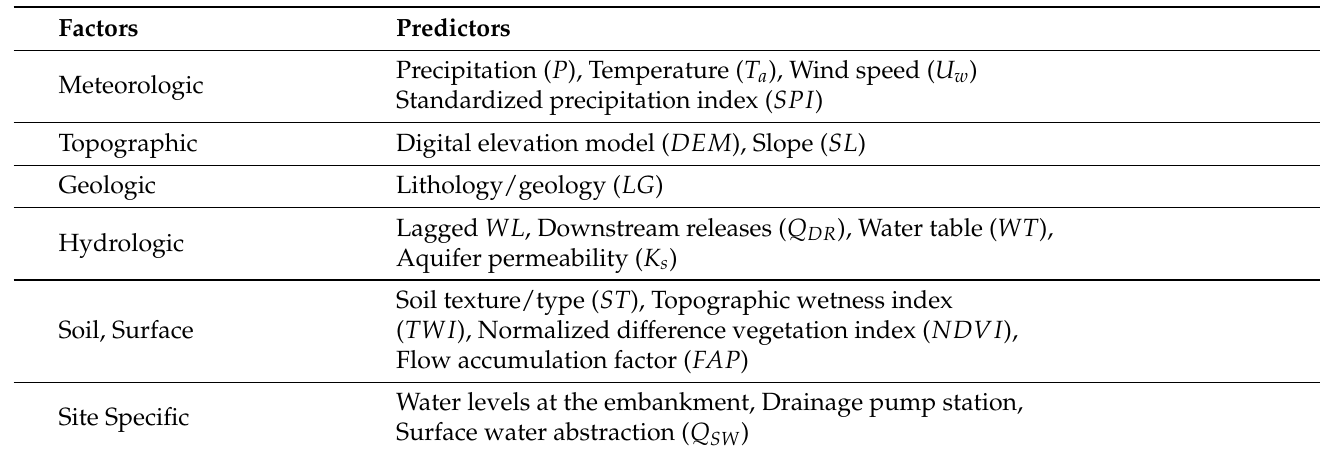
Table 5. Factors and predictors used in IAI-based water level